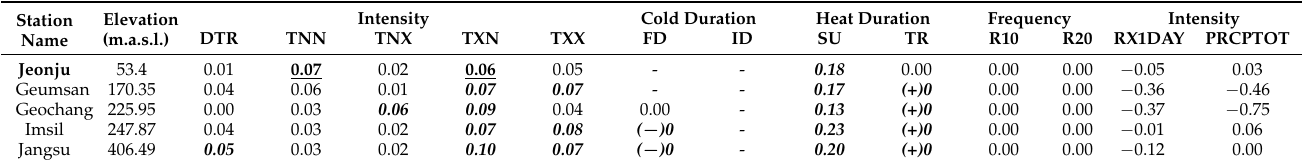
Table A11. Trend magnitudes for the month of May in the UGRB for 33 years (1988–2020).